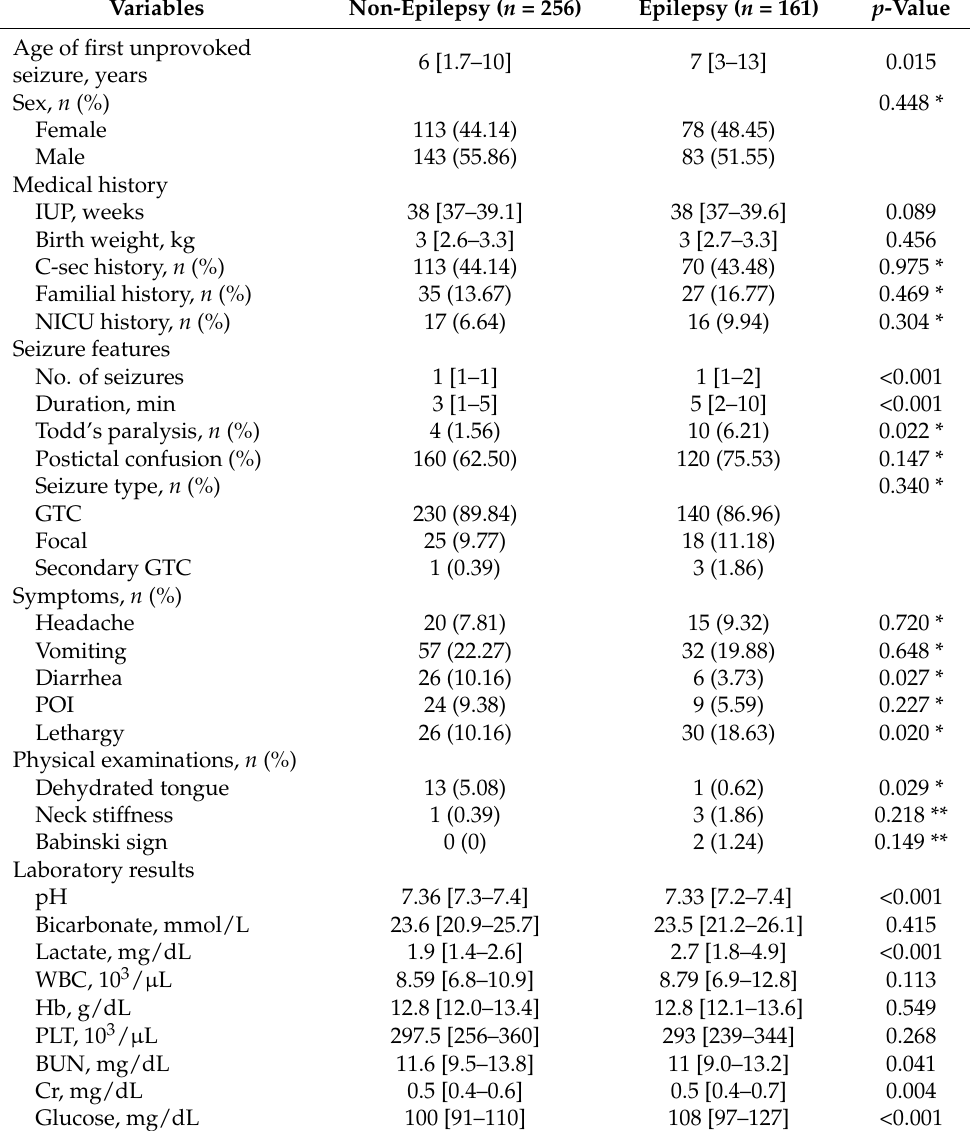
Table 1. Comparison of baseline characteristics between the two groups. Variables Non-Epilepsy ( n =